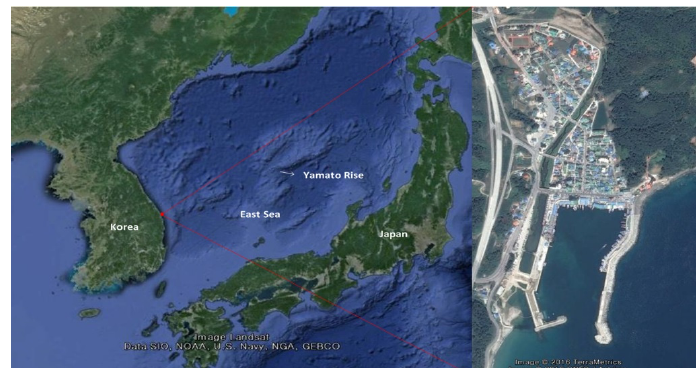
Figure 3. Location and map of Imwon Port. Table 2. Parameters for 11 hypothetical and 3 historical cases.